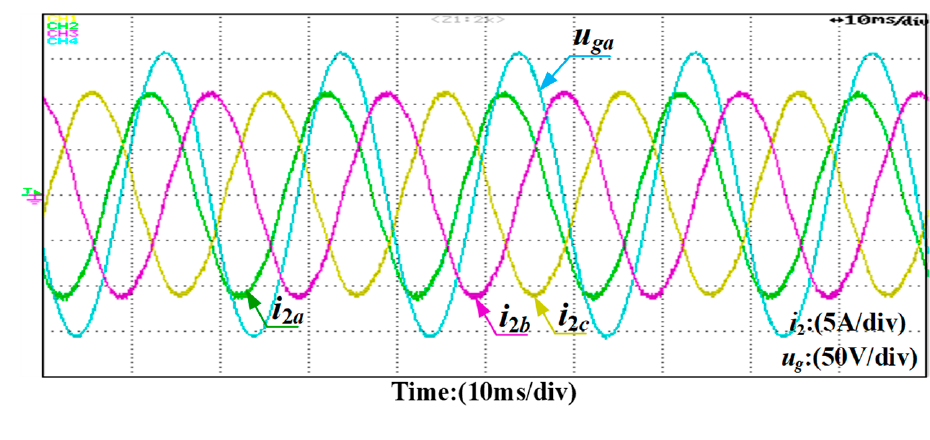
Figure 15. Steady state waveforms of the PCS for discharging operation.